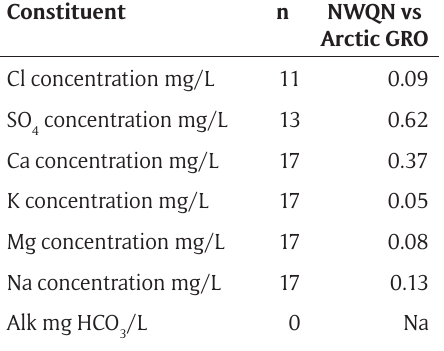
Table 5: Results of the paired t-test analysis compar- ing ION vs. “Professional” results (those from either NWQN or Arctic GRO). Values in the table represent the probability that concentrations or loads were the same. Probabilities have been adjusted for the number of comparisons made. * significant (p < 0.05) ** highly significant (p < 0.01). [n, number of samples; Cl, Chlo- ride; SO , Sulfate; Ca, Calcium; K, Potassium; Mg, Mag- 4 nesium; Na, Sodium; Alk, Alkalinty; mg/L miligrams per liter; HCO /L milligrams of bicarbonate per liter; ION, 3 Indigenous Observation Network; <, less